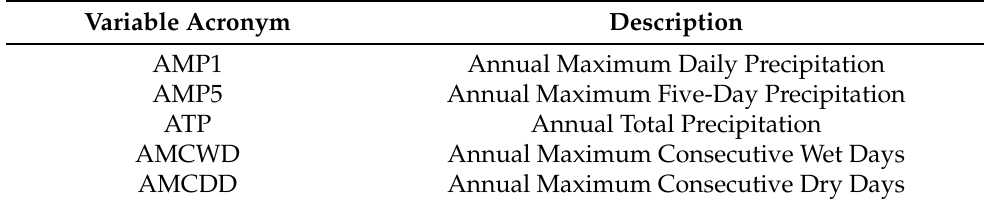
Table 1. The five climate variables considered in this